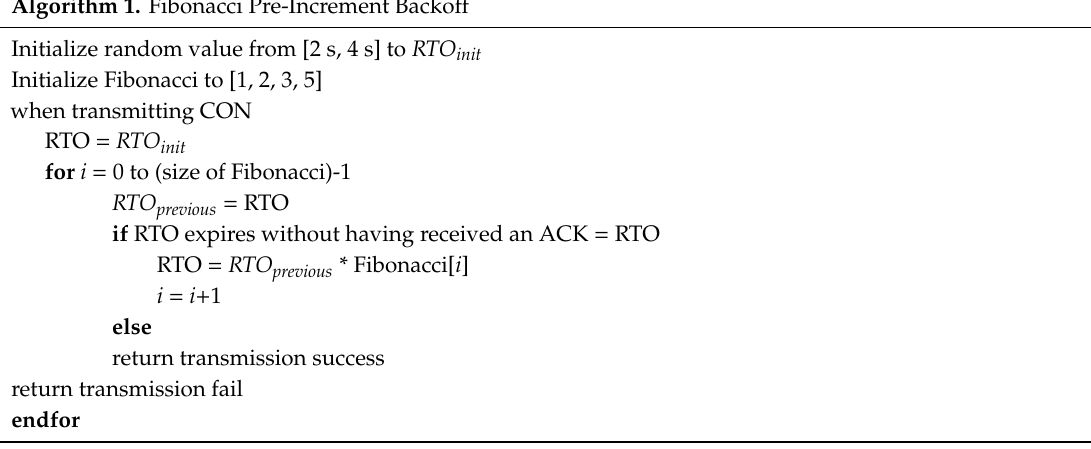
Algorithm 1. Fibonacci Pre-Increment Backo